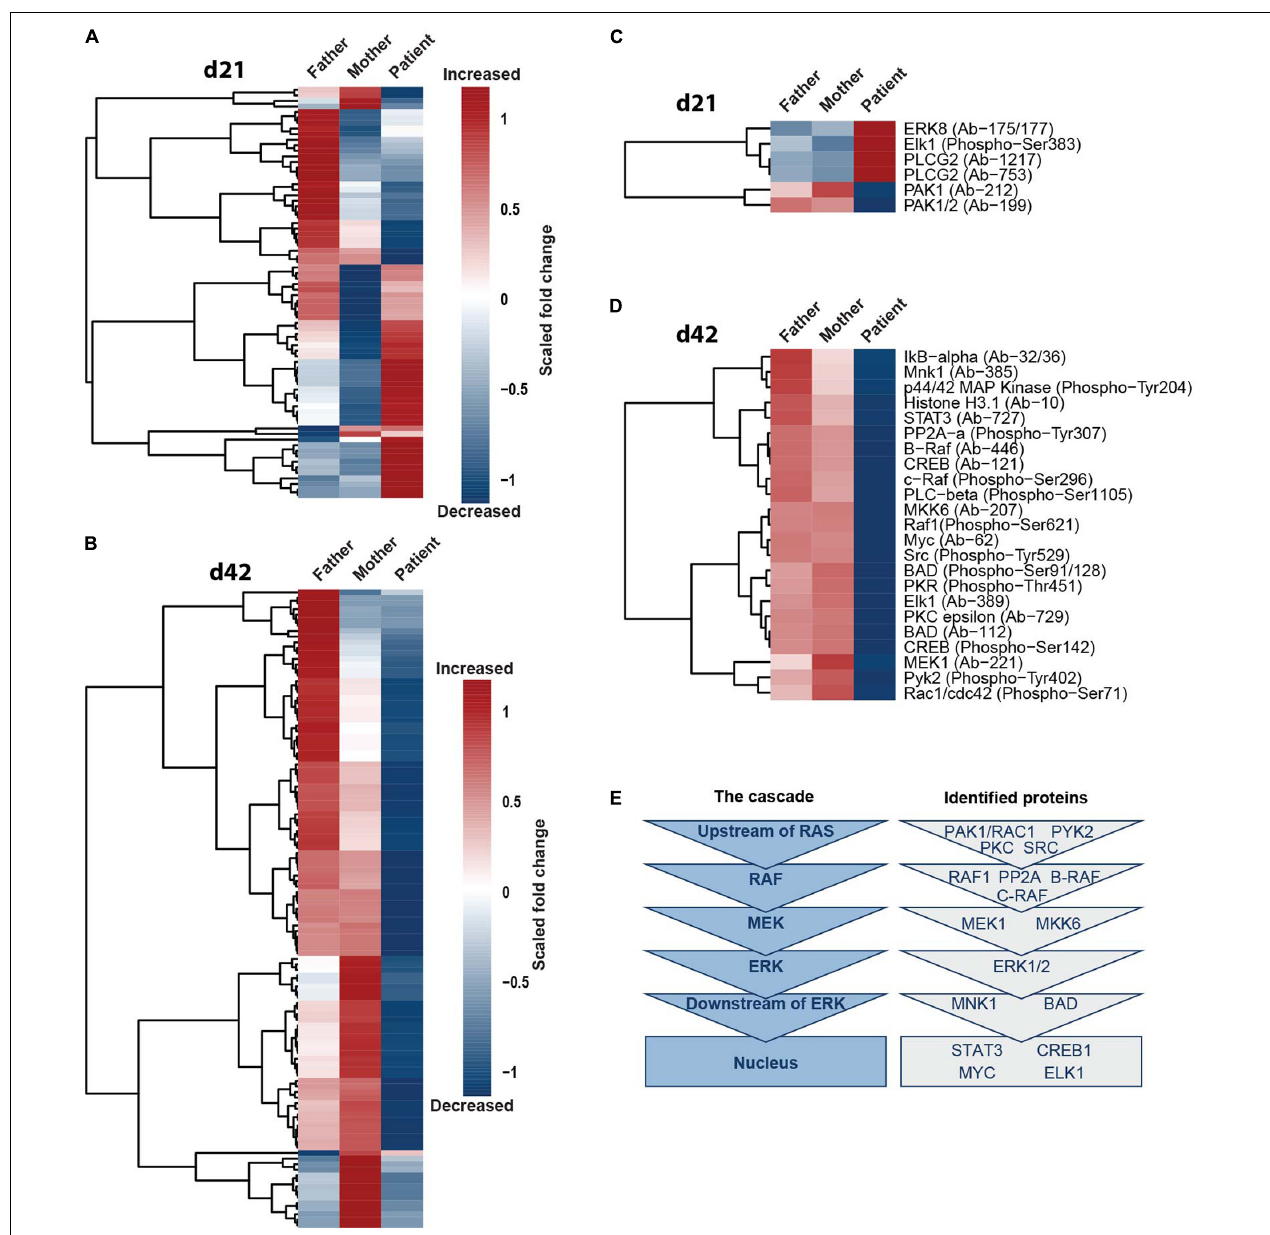
FIGURE 5 | SHANK2 deletion affects the ERK1/2 signaling pathway in general. (A,B) Full Moon array with neurons d21 (A) and d42 (B) . Scored fold change to the mean of maternal and paternal measurements per protein is shown, n = 3. (C,D) Neurons d21 (C) and neurons d42 (D) . Data were filtered for proteins with a fold change of either 0.45 greater or smaller for both a mother and a father in comparison to the patient. (E) Attributing the proteins filtered in (C,D) to the six main hierarchies in the ERK1/2 signaling pathway upstream of RAS, RAF, MEK, ERK, downstream of ERK, and in the